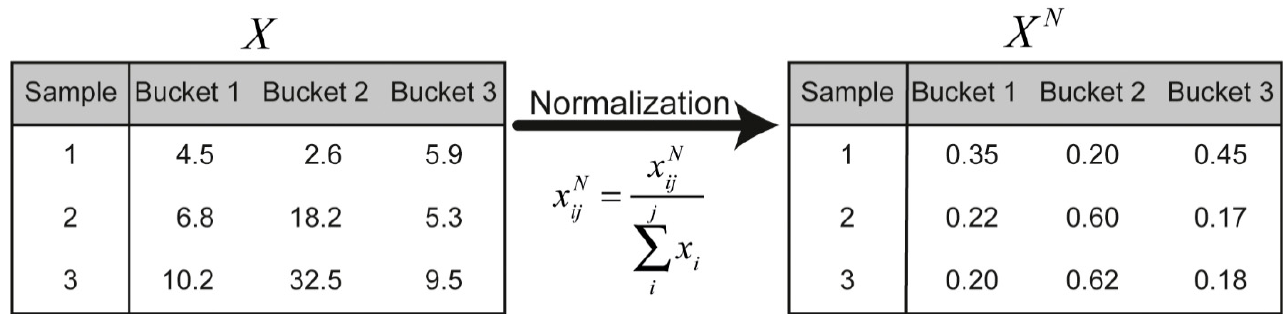
Molecules 2021 , 26 , x FOR PEER REVIEW 7 of 19 Figure 4. Truncated NMR spectrum before and after bucketing into equally spaced buckets of 0.04 ppm width. Bucketing allows for moderate shift averaging at the expense of resolution and provides a matrix for further processing. The disadvantage of equally spaced buckets is that peaks split between two or more buckets and influence the data analysis. There are several methods, e.g., adaptive-intelli- gent bucketing, Gaussian bucketing, adaptive bucketing using wavelet transformation